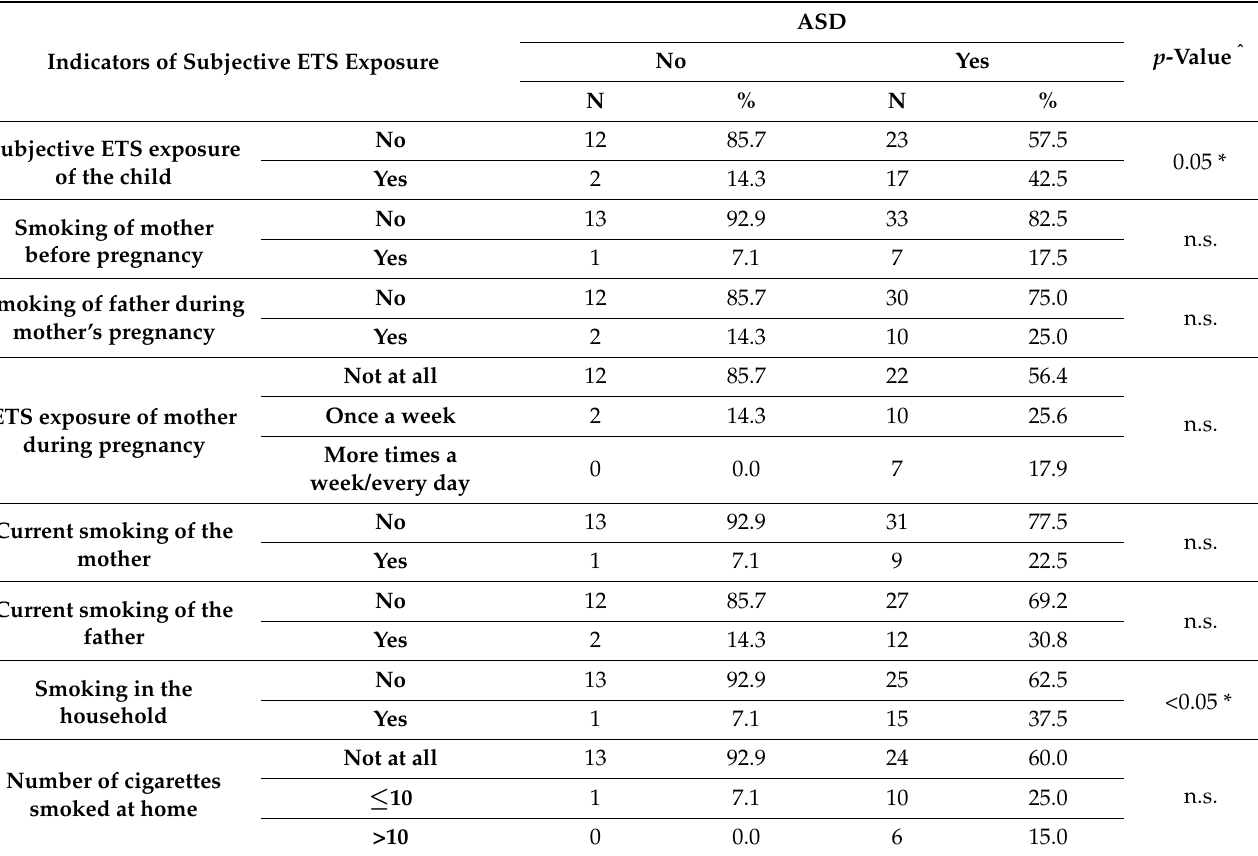
Table 4. Subjective ETS exposure relating to the presence of ASD ( n =